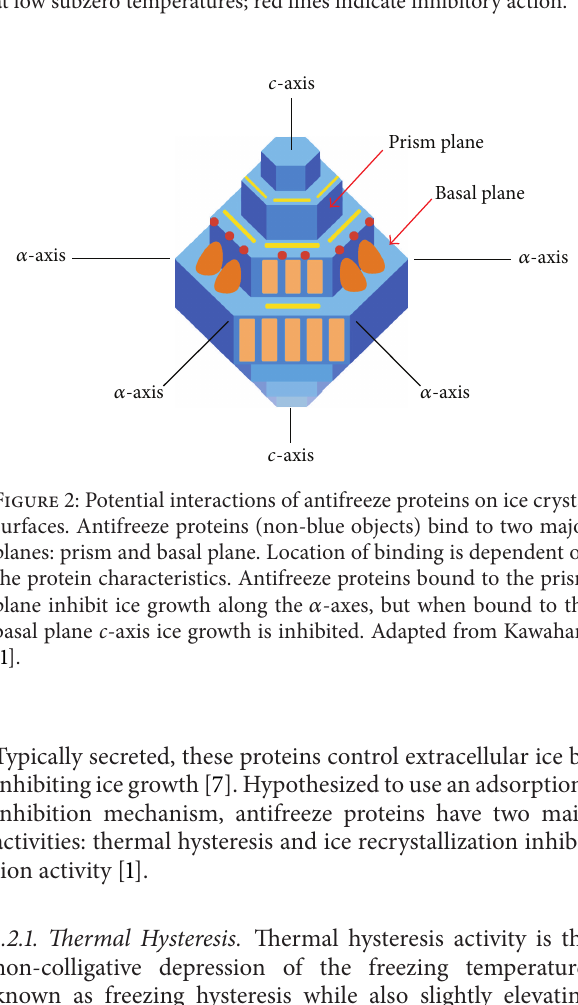
Figure 1: The interactions of ice crystal controlling proteins on the two stages of ice crystal growth. Ice nucleation proteins induce growth of single ice crystal nuclei, while antifreeze proteins inhibit further ice crystal growth. Blue lines represent ice growth direction at low subzero temperatures; red lines indicate inhibitory action.